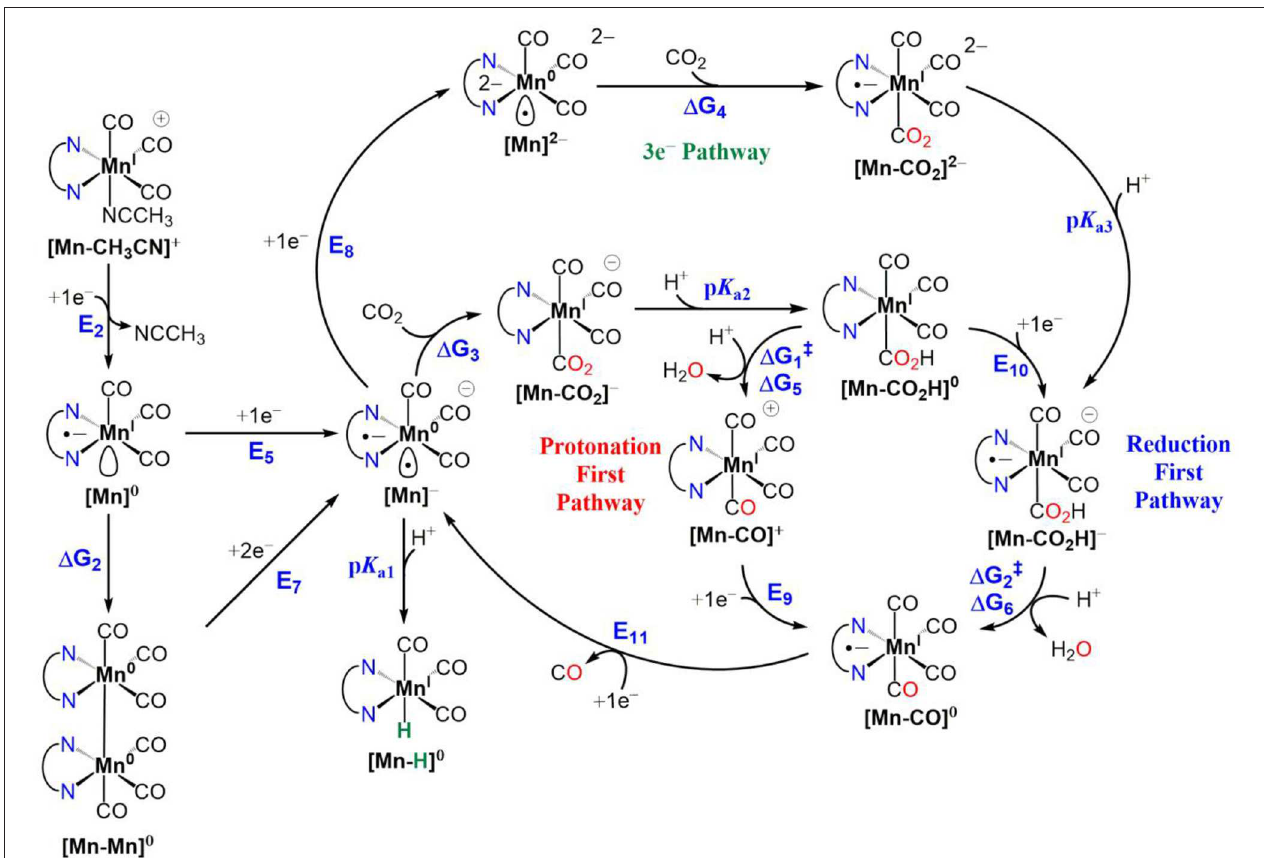
( Figure S38 ) and total electron density difference ( Figure S39